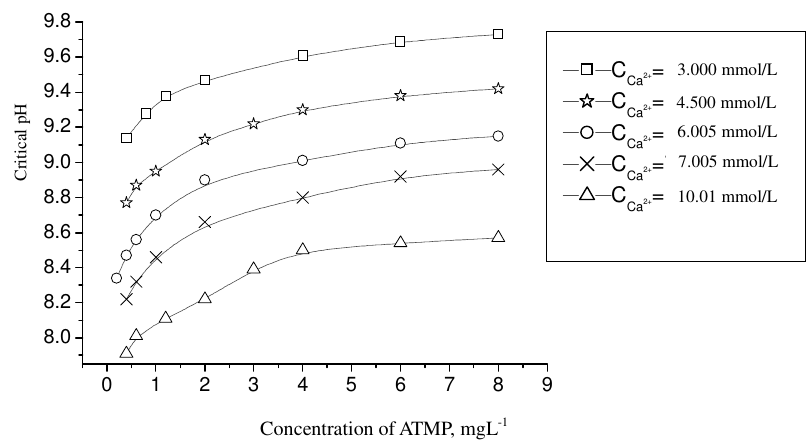
Figure 3. Variation of critical pH with ATMP concentration in several cooling water containing different concentrations of Ca